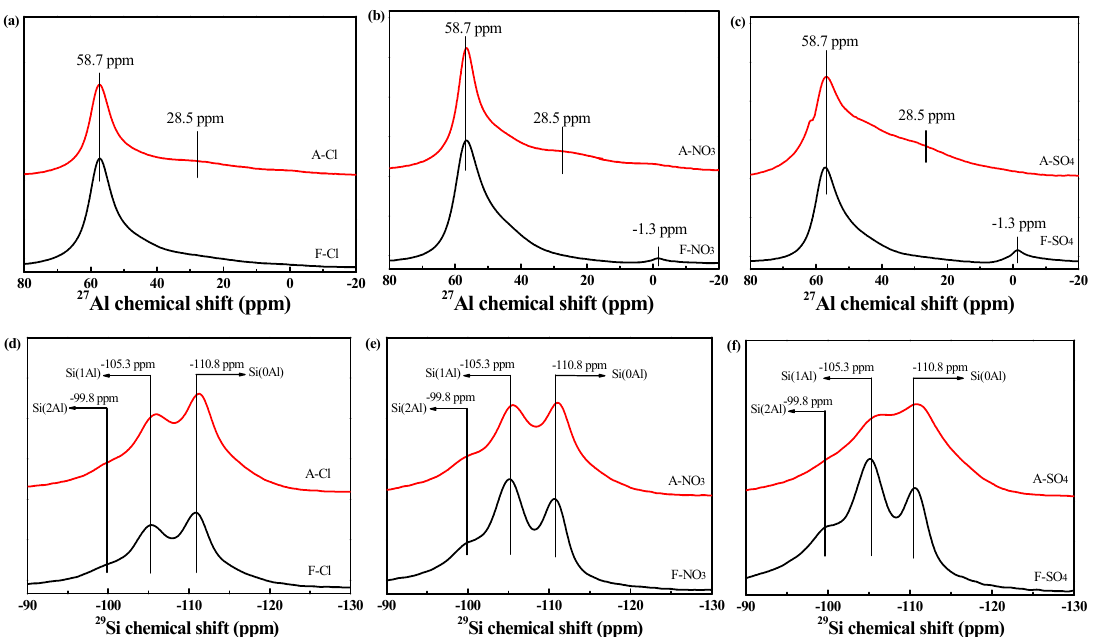
Figure 6. Solid state 27 Al-Nuclear Magnetic Resonance (NMR) ( a – c ) and 29 Si-NMR ( d – f ) spectra of Cu II − SSZ − 13 catalysts before and after hydrothermal aging treatment.